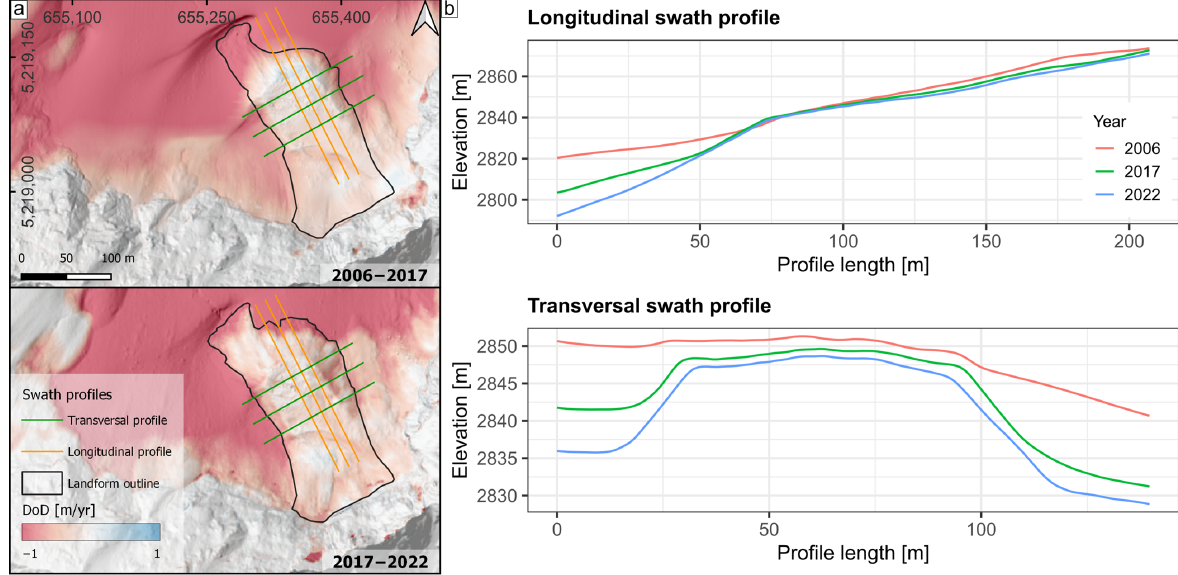
Figure 3. ( a ) Mean annual surface elevation change in the landform and the surrounding glacier. ( b ) Mean elevation in the transverse and longitudinal swath profiles (50 m), represents the mean change in the shape of the landform. The locations of the profiles are shown in Figure 3a.